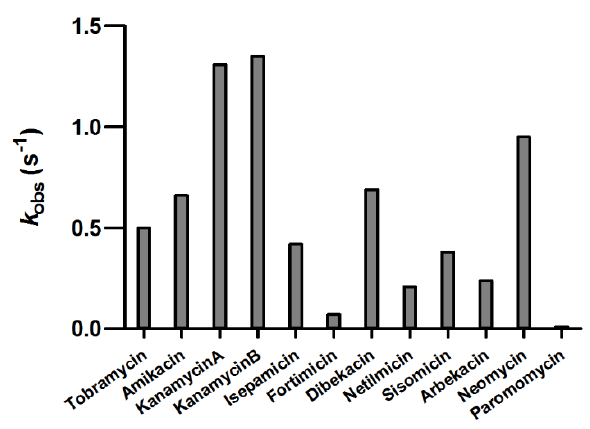
FIGURE 2: The rate constants for the acetyltransferase activity of AAC(6’)-Im for selected aminoglycosides.